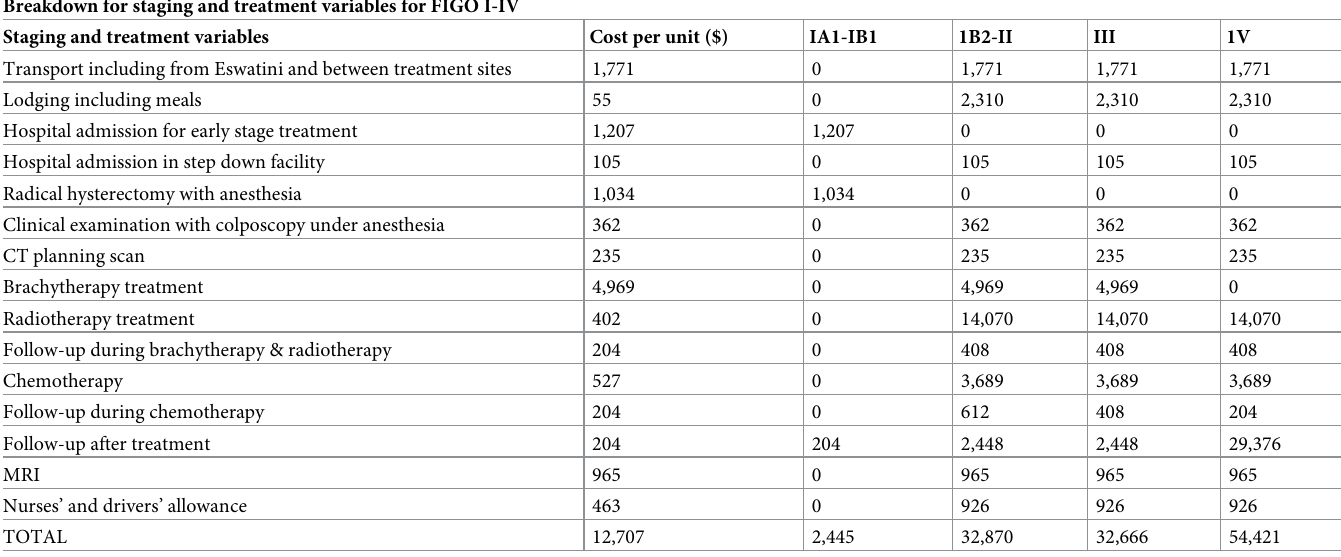
Table 4. Costs for staging, management and treatment of cervical cancer per FIGO stage I-IV expressed in 2018 USD average exchange rate of $1 = SZL14.5. Breakdown for staging and treatment variables for FIGO I-IV Staging and treatment variables